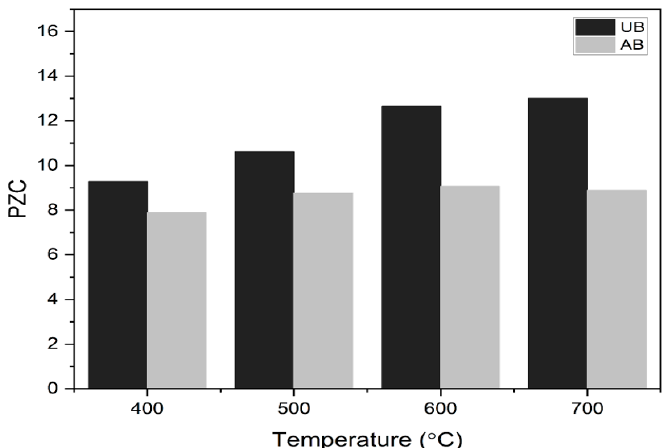
Figure 3. Point of zero charge of unactivated biochar (UB) and activated biochar (AB) synthesized at various pyrolysis temperatures of 400–700 °C.